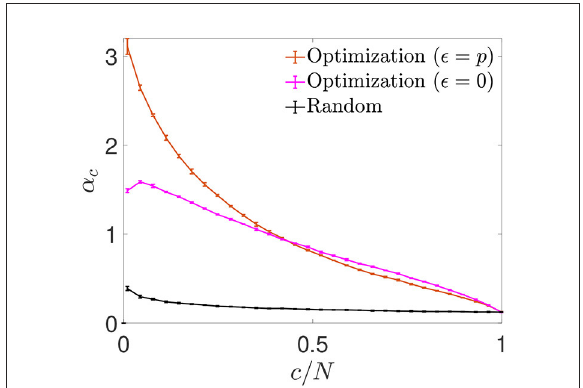
FIGURE6 Storage capacity of optimized and random networks. Critical storage capacity vs. connectivity ratio for networks ( N = 2,000) with random connectivity (black) or connectivity optimized by signal reinforcement (orange) or noise reduction (magenta) (mean ± s.d.). Pool of data corresponding to five simulations for each connectivity. T -test comparisons for data in the lowest connectivity values show significant differences between the storage capacity of random networks and that of noise reduction ( p -value: 10 − 6 ) or signal reinforcement ( p -value: 10 − 7